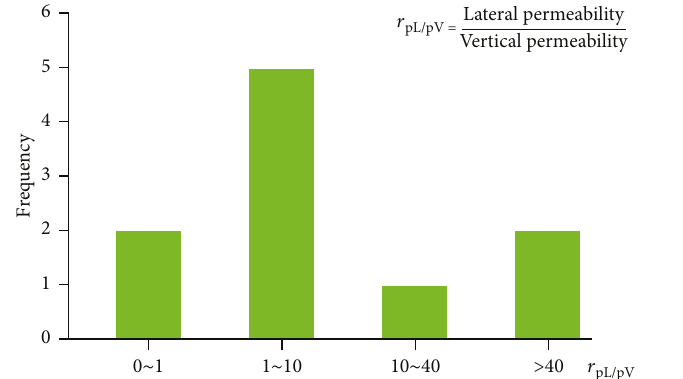
Figure 7: The ratio of lateral and vertical permeability of the lower Cambrian of Jiangye-1 and Jiangye-2. See Figure 1 for the well